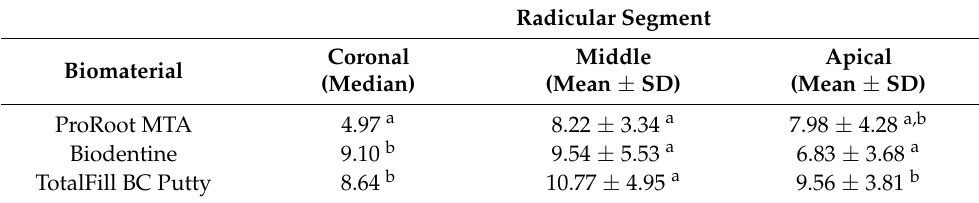
Table 3. Push-out bond strength values (MPa) according to radicular